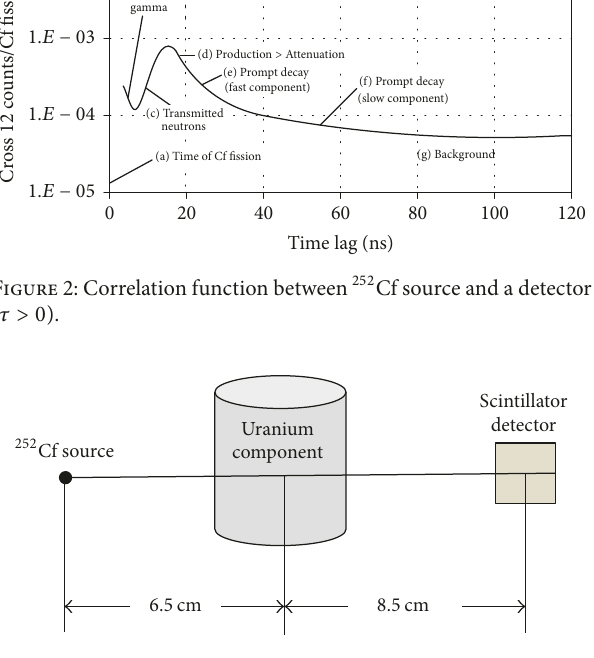
Figure 3: Structure of the simulation